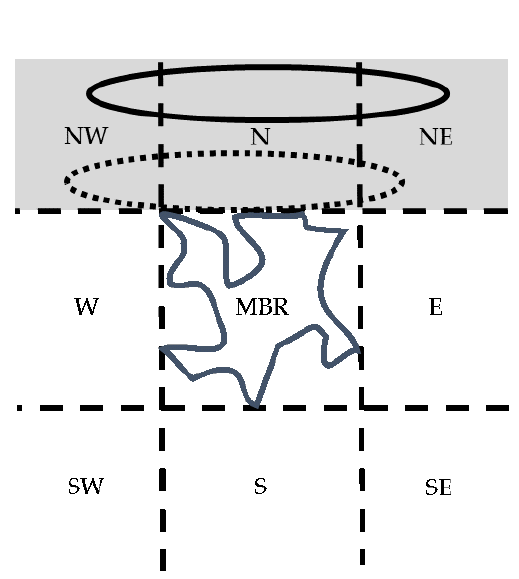
Figure 8: An example of two objects producing the same direction relation matrix that have two different topological relations: disjoint (solid) or meet (dotted).